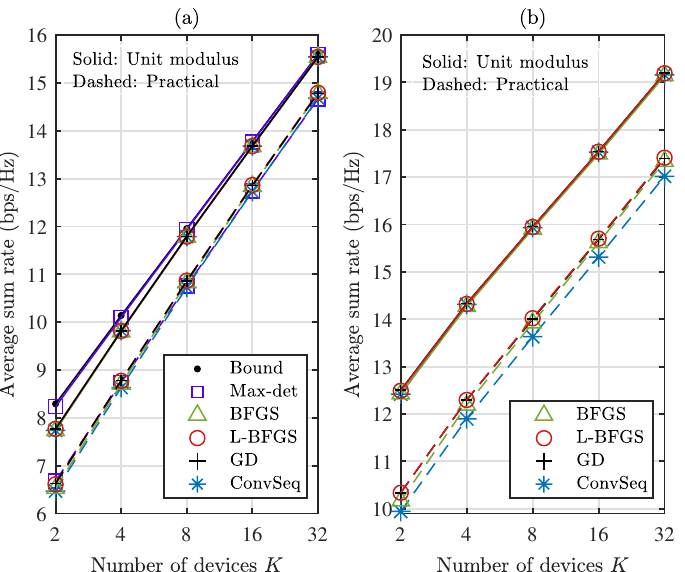
Figure 5. Average sum rate as the number K of devices increases when M = 2 and K = 4: ( a ) N = 64 ( b ) N = 256.